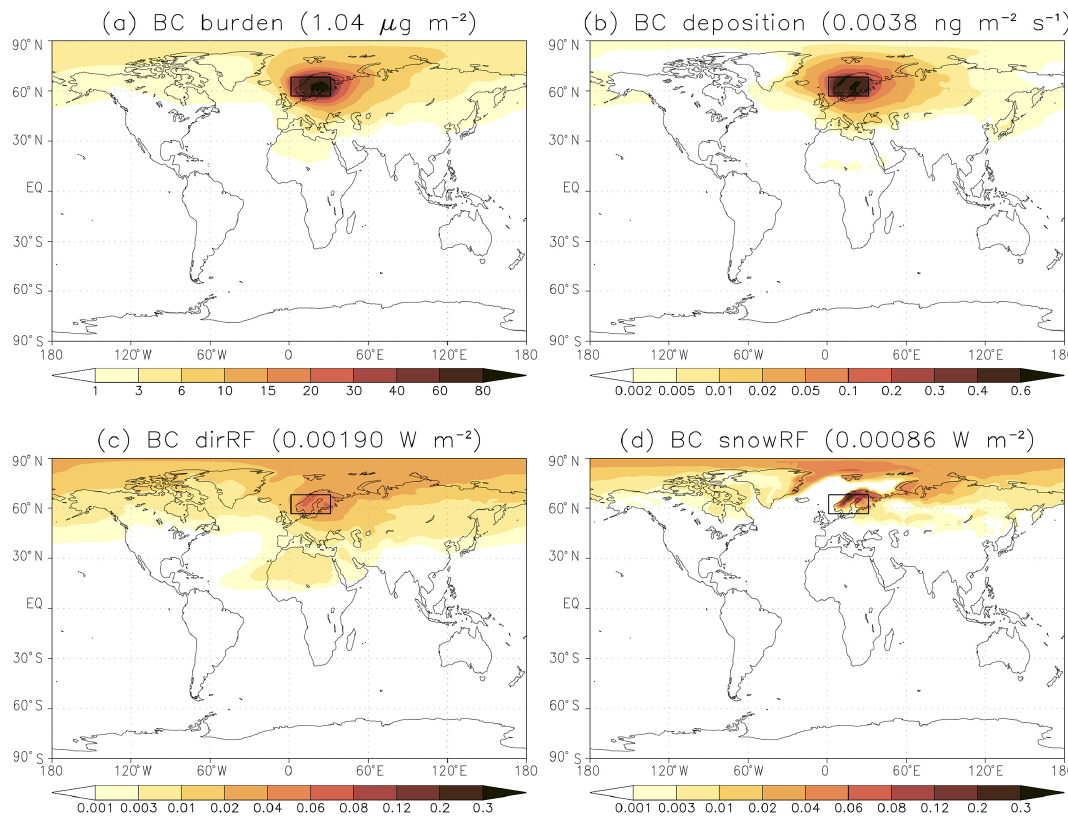
Figure 3. Annual mean fields in the experiment in which a constant BC emission rate of 10 − 12 kgm − 2 s − 1 was applied in the lat–long box 56.84–68.21 ◦ N, 1.25–31.25 ◦ E (shown with a rectangle). (a) BC burden (in units of µgm − 2 = 10 − 9 kgm − 2 ). (b) Total BC deposition rate (in units of ngm − 2 s − 1 = 10 − 12 kgm − 2 s − 1 ). (c) BC direct radiative forcing (Wm − 2 ). (d) Radiative forcing due to BC in snow (Wm − 2 ). Global mean values are given in the panel headings (in